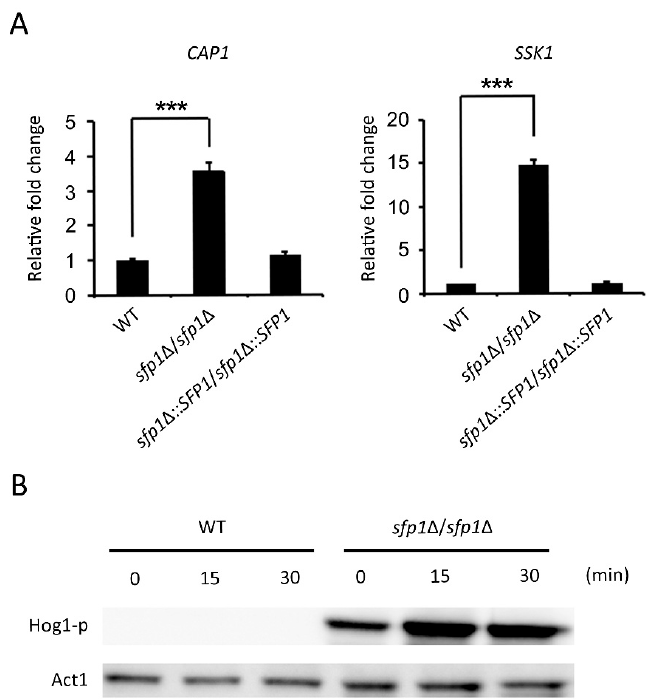
Figure 7. Hog1 signaling and the Cap1 transcription factor are related to the Sfp1-mediated oxidative stress response. ( A ) Gene expression levels of CAP1 and SSK1 were analyzed using real-time qPCR.